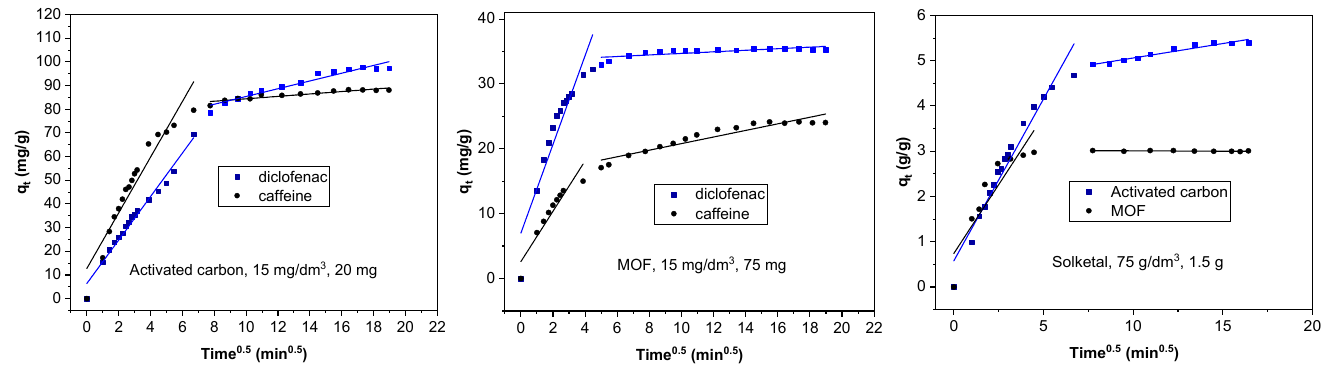
Figure 3. Intraparticle-diffusion model for the adsorption of organic molecules on the AC and MOF.